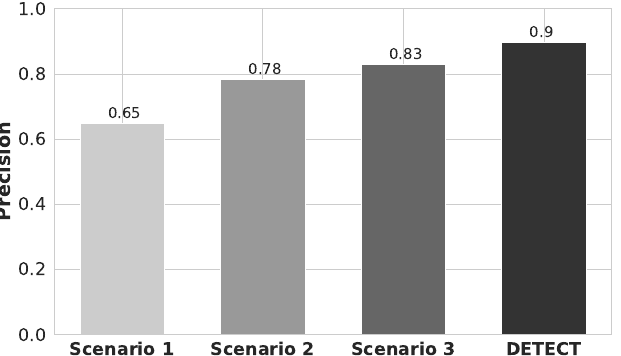
Figure 8. Precision results for each scenario of data improvement.